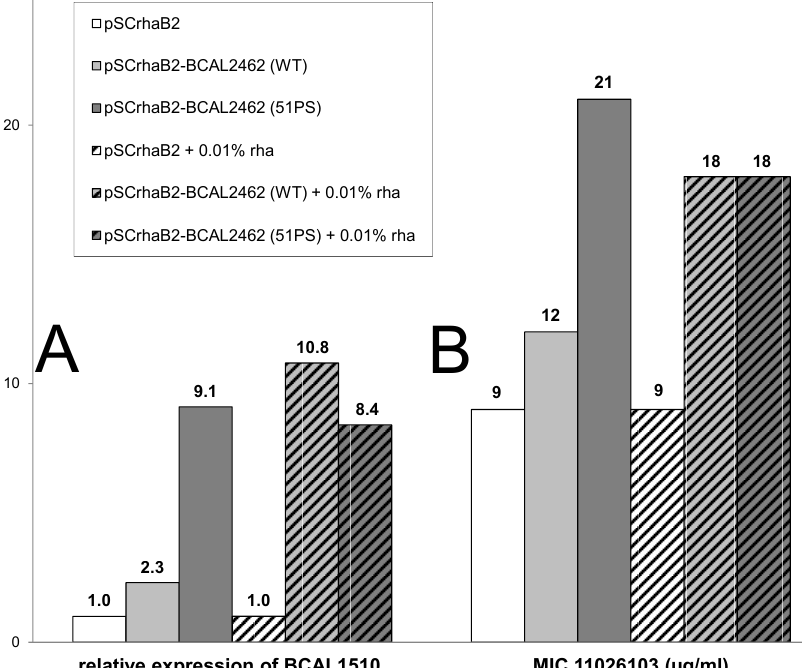
Figure 2. The effect of artificial expression of BCAL2462 (wild-type (WT) or 51P → S allele) in B. cenocepacia J2315 on ( A ) expression of major facilitator superfamily (MFS) transporter BCAL1510; ( B ) MIC of 11026103. Expression changes were calculated in comparison with empty vector control experiment (J2315 + pSCrhaB2 with or without rhamnose).